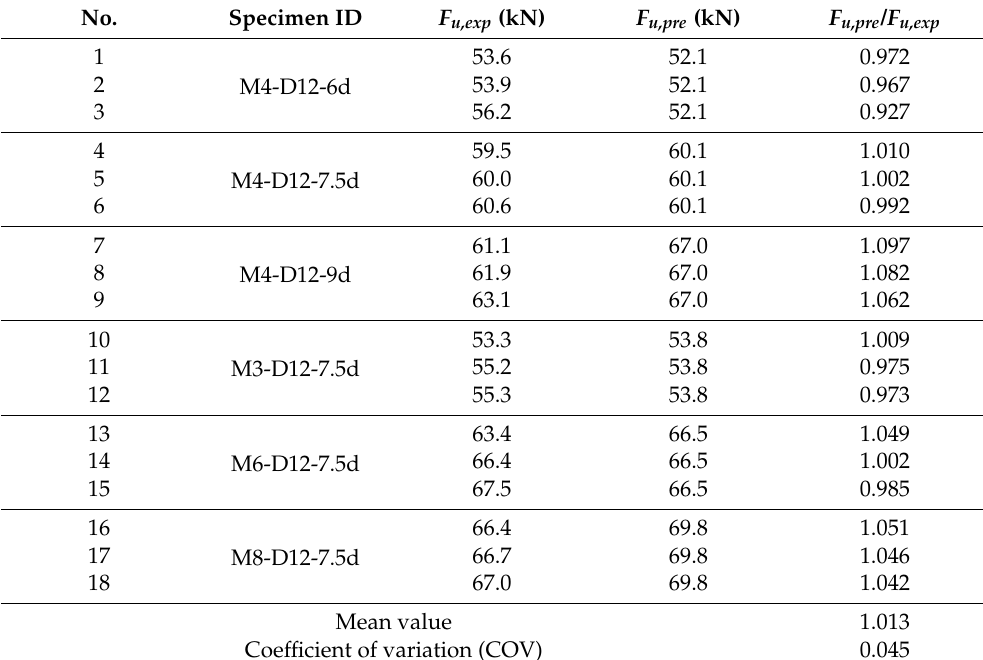
Table 5. Comparison between test data and predicted